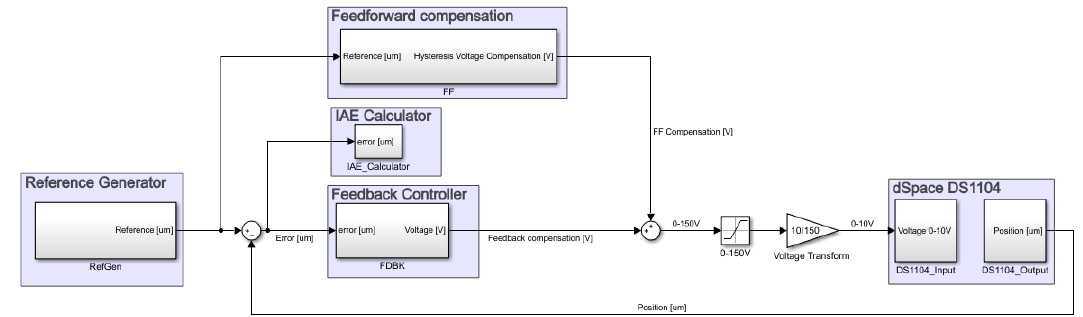
Figure 4. FF with feedback control architecture design in Simulink for implementation in